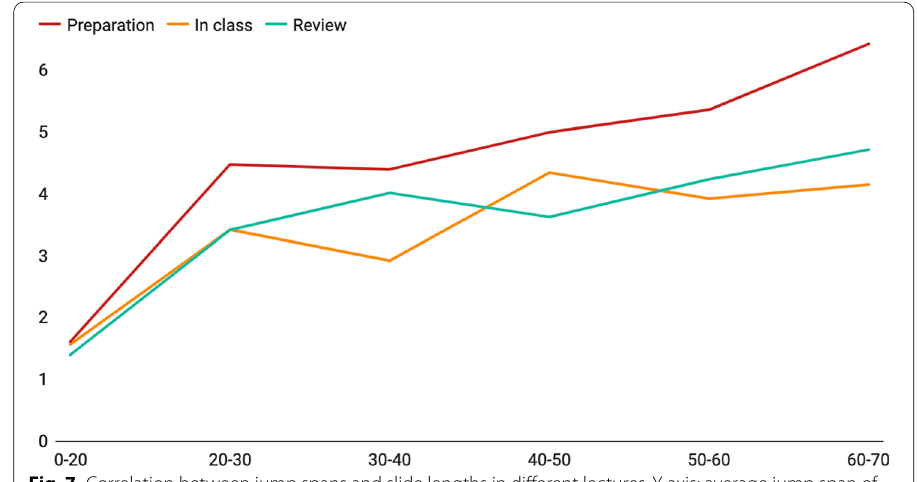
Fig. 7 Correlation between jump spans and slide lengths in different lectures. Y-axis: average jump span of each group, X-axis: page length for each group